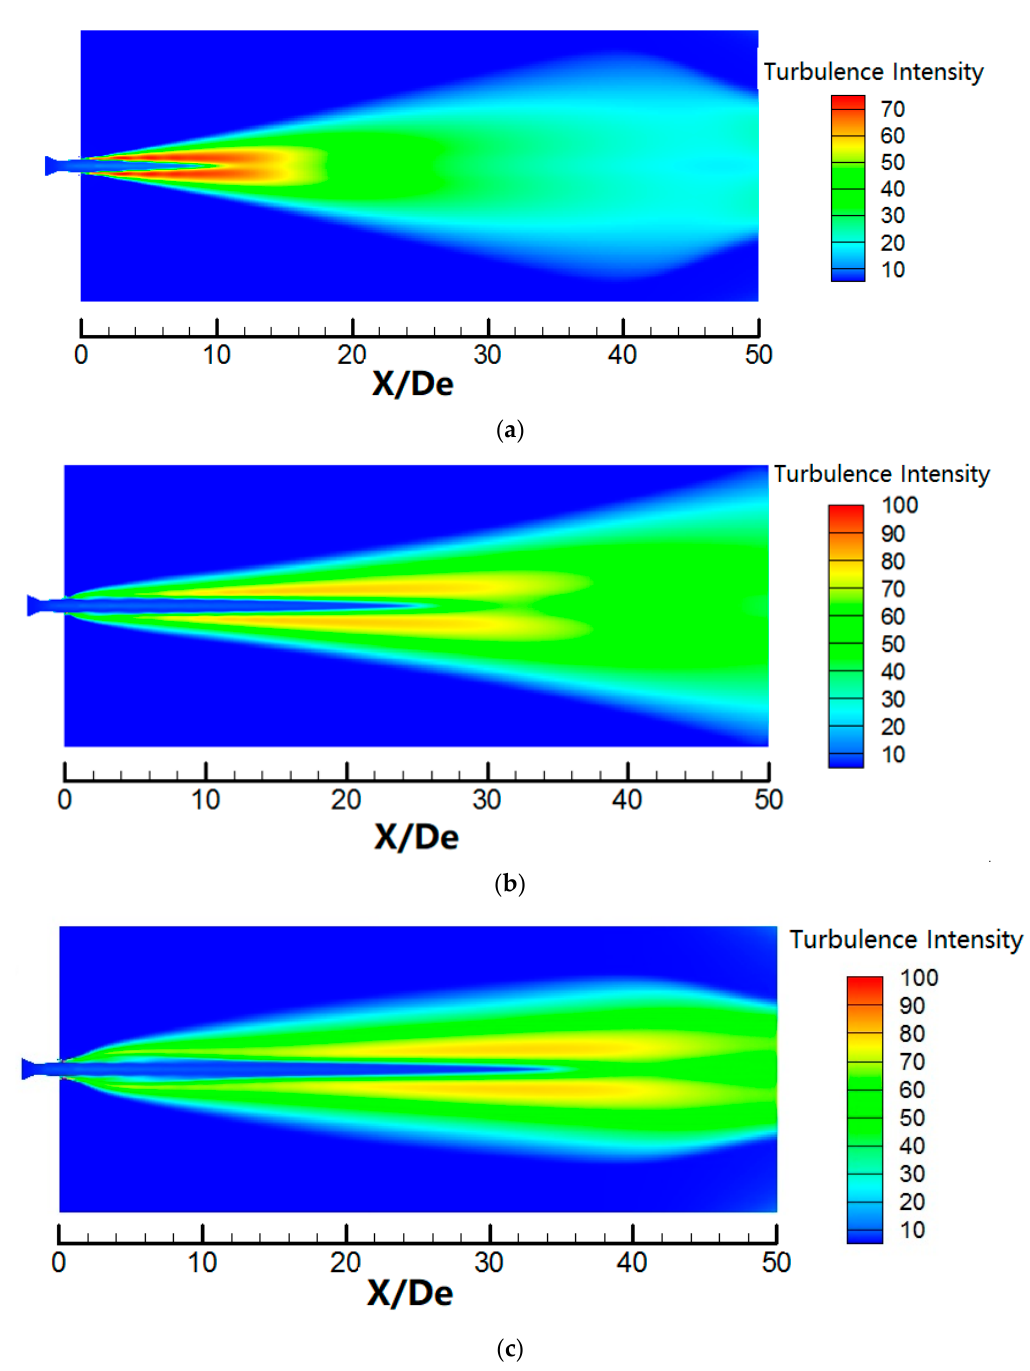
Figure 11. Turbulence intensity contours for three jets: ( a ) supersonic jet; ( b ) coherent jet; and ( c ) SC coherent jet.